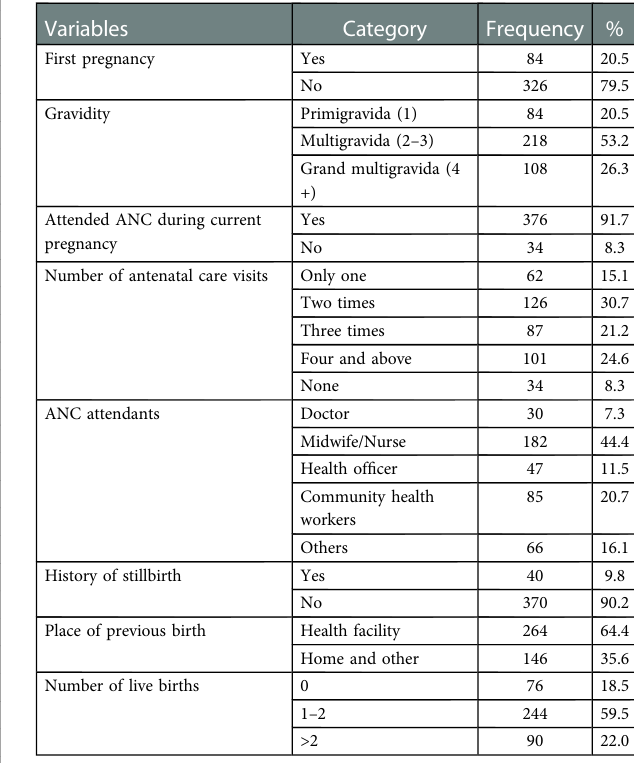
TABLE 2 Past obstetric history of pregnant women in Hosanna Zuria Kebeles, Hadiya Zone, southern Ethiopia, 2021 ( N =410